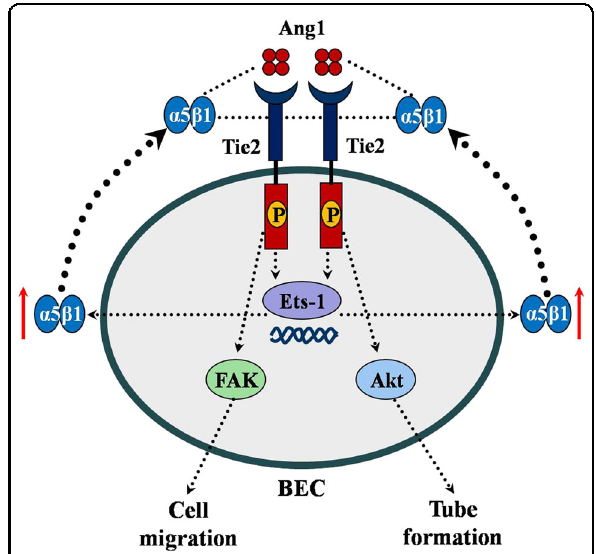
Fig. 8 Schematic representation of Ang1/Tie2 and integrin α 5 cooperative signaling in brain endothelial cell regulation. Following OGD, Ang1/Tie2 is upregulated, which cooperates with integrin α 5 to induce Tie2 activation and the phosphorylation of its downstream signaling molecules FAK and Akt in BECs, resulting in the increase of migration and capillary-like tube formation of BECs. Additionally, priming of BECs with Ang1 promotes the expression of α 5 integrin through Ets-1 signaling after OGD. Abbreviations: angiopoietin-1, Ang1; brain endothelial cells, BECs; v-ets erythroblastosis virus E26 oncogene homolog-1, Ets-1; focal adhesion kinase, FAK; phosphorylation,